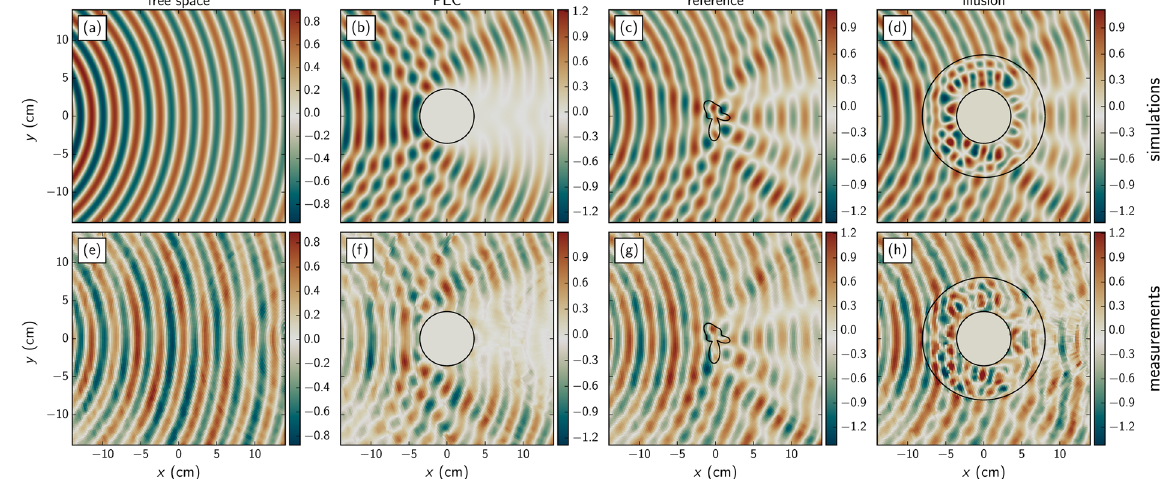
Figure 2. Field maps. Real part of the dielectric field at the design frequency f = 10 GHz. Top row ( a – d ) FEM simulations. Bottom row ( e – h ) measurements. Various case are considered: free space ( a , e ), PEC cylinder ( b , f ), reference dielectric object ( c , g ) and the same PEC cylinder with the proposed illusion device ( d , h ).